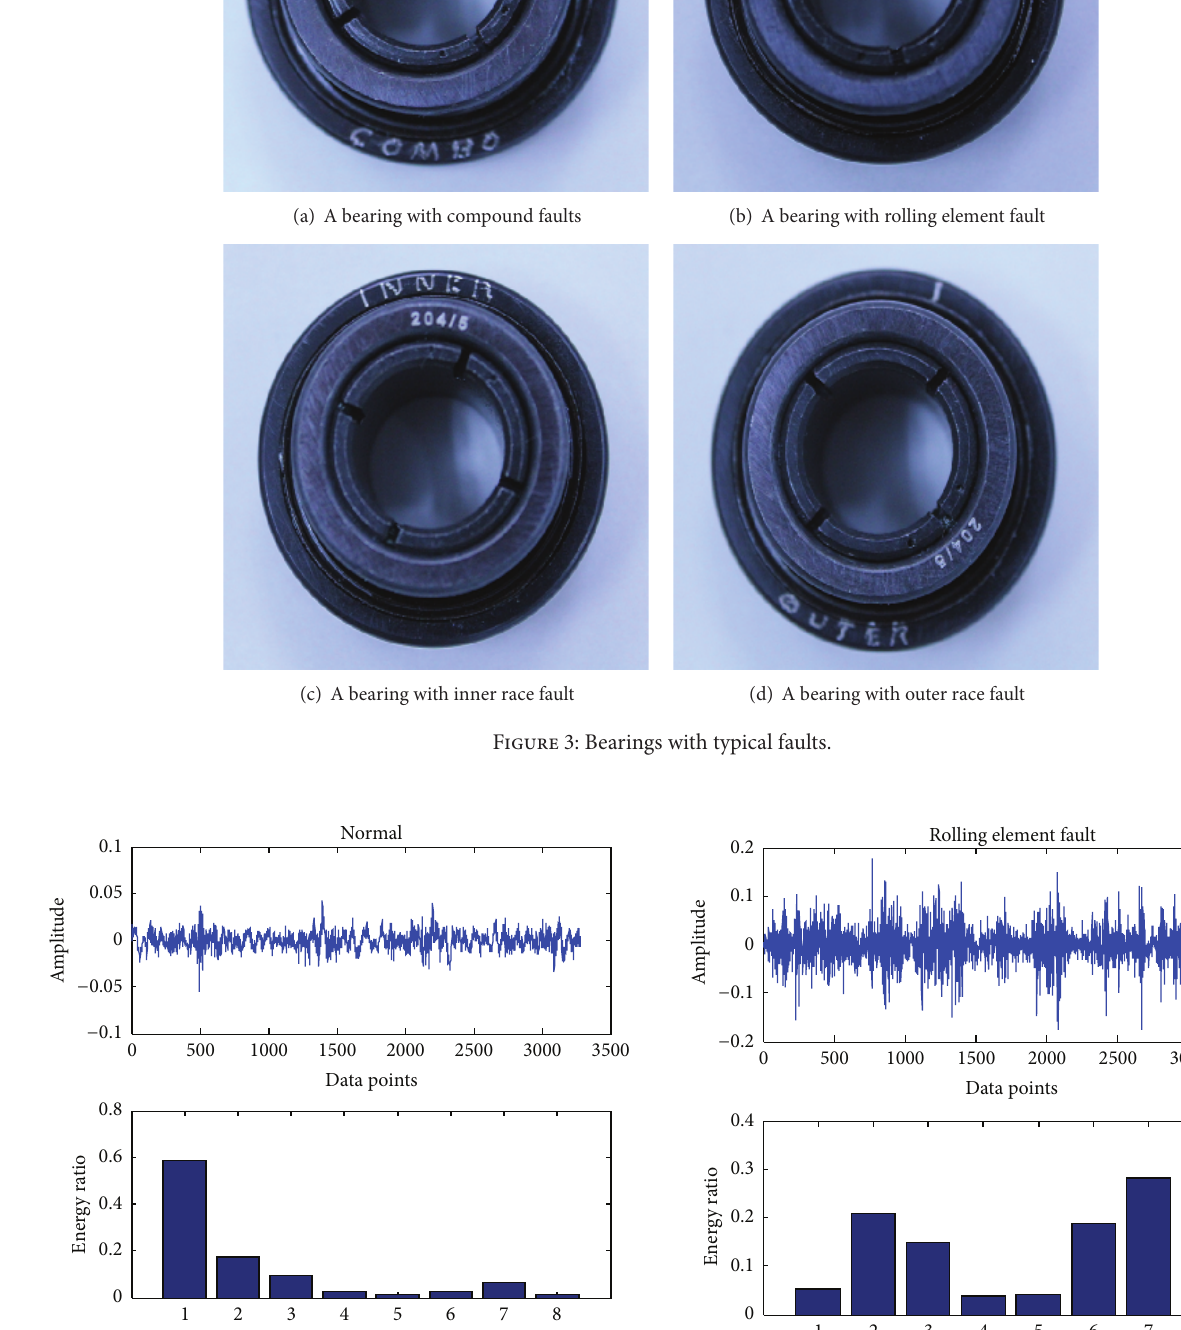
Figure 5: Rolling element